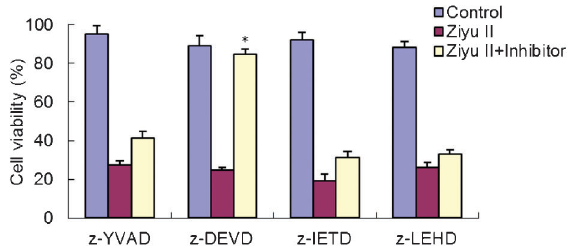
Figure 5. Effect of caspase inhibitors on ziyuglycoside II-induced BGC-823 cell apoptosis. Cells were pretreated with or without caspase inhibitor (20 m M) for 1 h and then cultured with ziyuglycoside II (Ziyu II, 25 m M) for 12 h. Caspase-1 inhibitor (z-YVAD-fmk: z-Tyr-Val-Ala-Asp-fluoromethylketone), caspase-3 inhibitor (z-DEVD-fmk: z-Asp-Glu-Val-Asp-fluoromethylketone), caspase-8 inhibitor (z-IETD-fmk: z-Ile-Glu-Thr-Asp-fluoro- methylketone), caspase-9 inhibitor (z-LEHD-fmk: z-Leu- Glu(OMe)-His-Asp(OMe)-fluoromethylketone). After incubation, cell viability was assessed. Data are reported as means±SD for n=3 independent assays. *P , 0.05 vs ziyuglycoside II-treated (Student t -test).